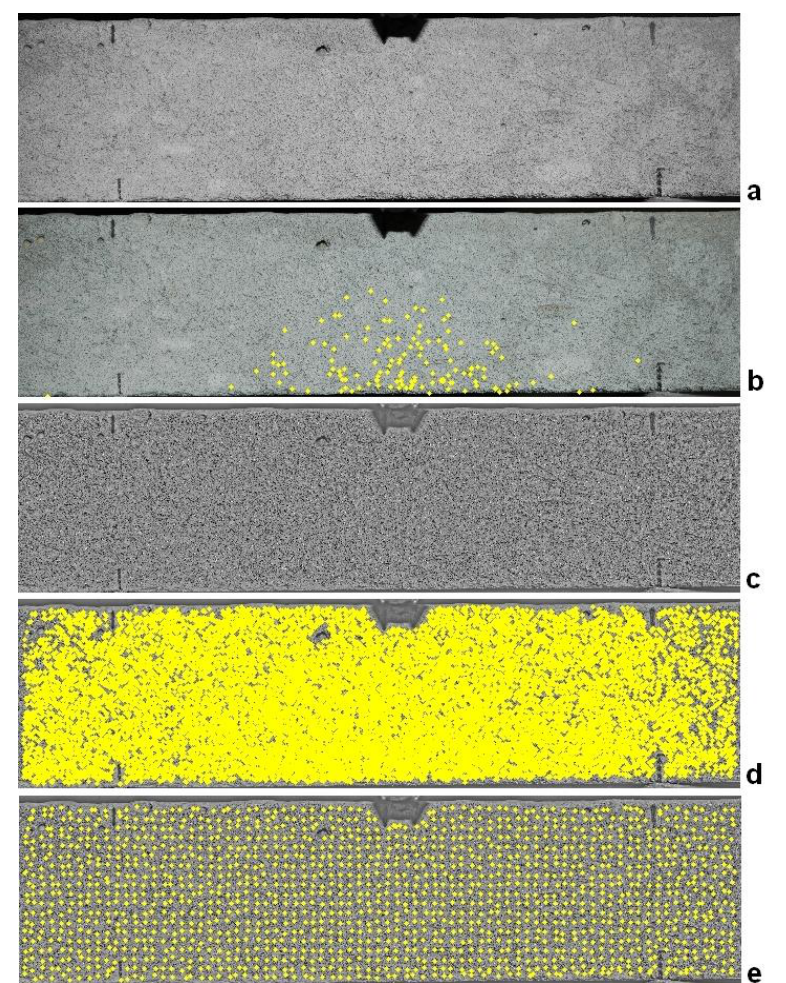
Figure 7. Results in the case of markerless image sequences: (a) original image and (b) extracted corners, (c) filtered image and (d) extracted corners, (e) corner reduction according to a quasi regular